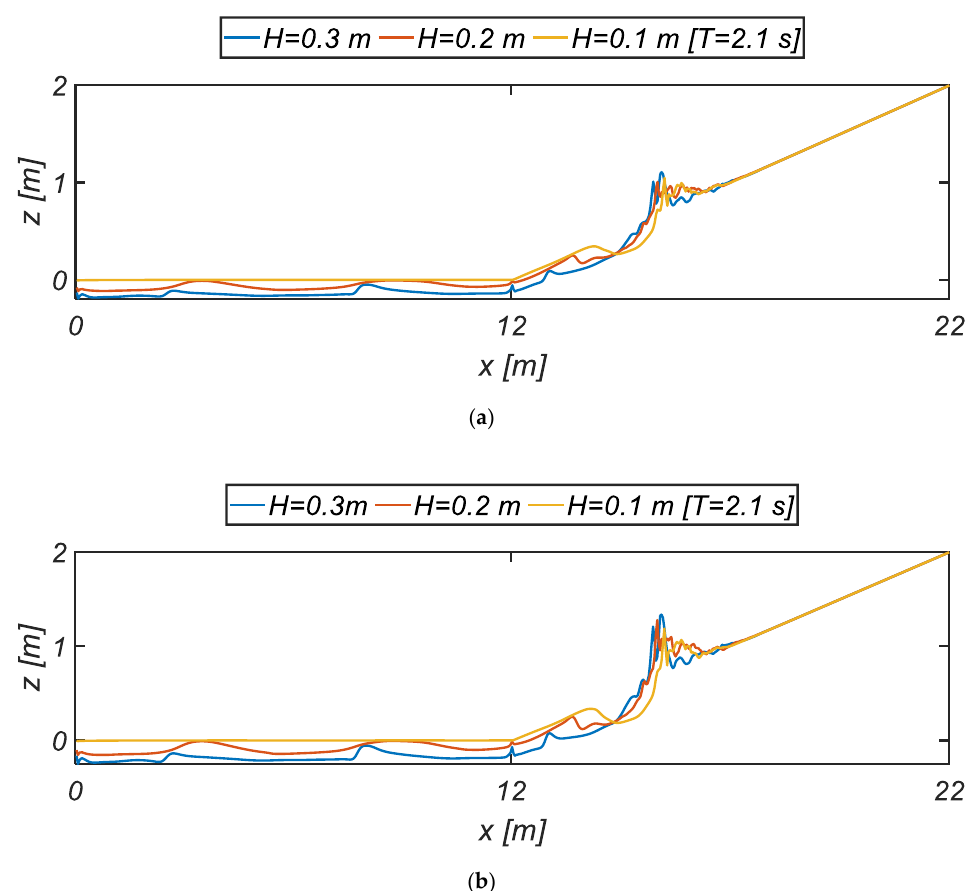
Figure 15. Comparison of beach morphology’s change as the number of attacking waves is accumulated. ( a ) at t = 75 s; ( b ) at t = 100 s.